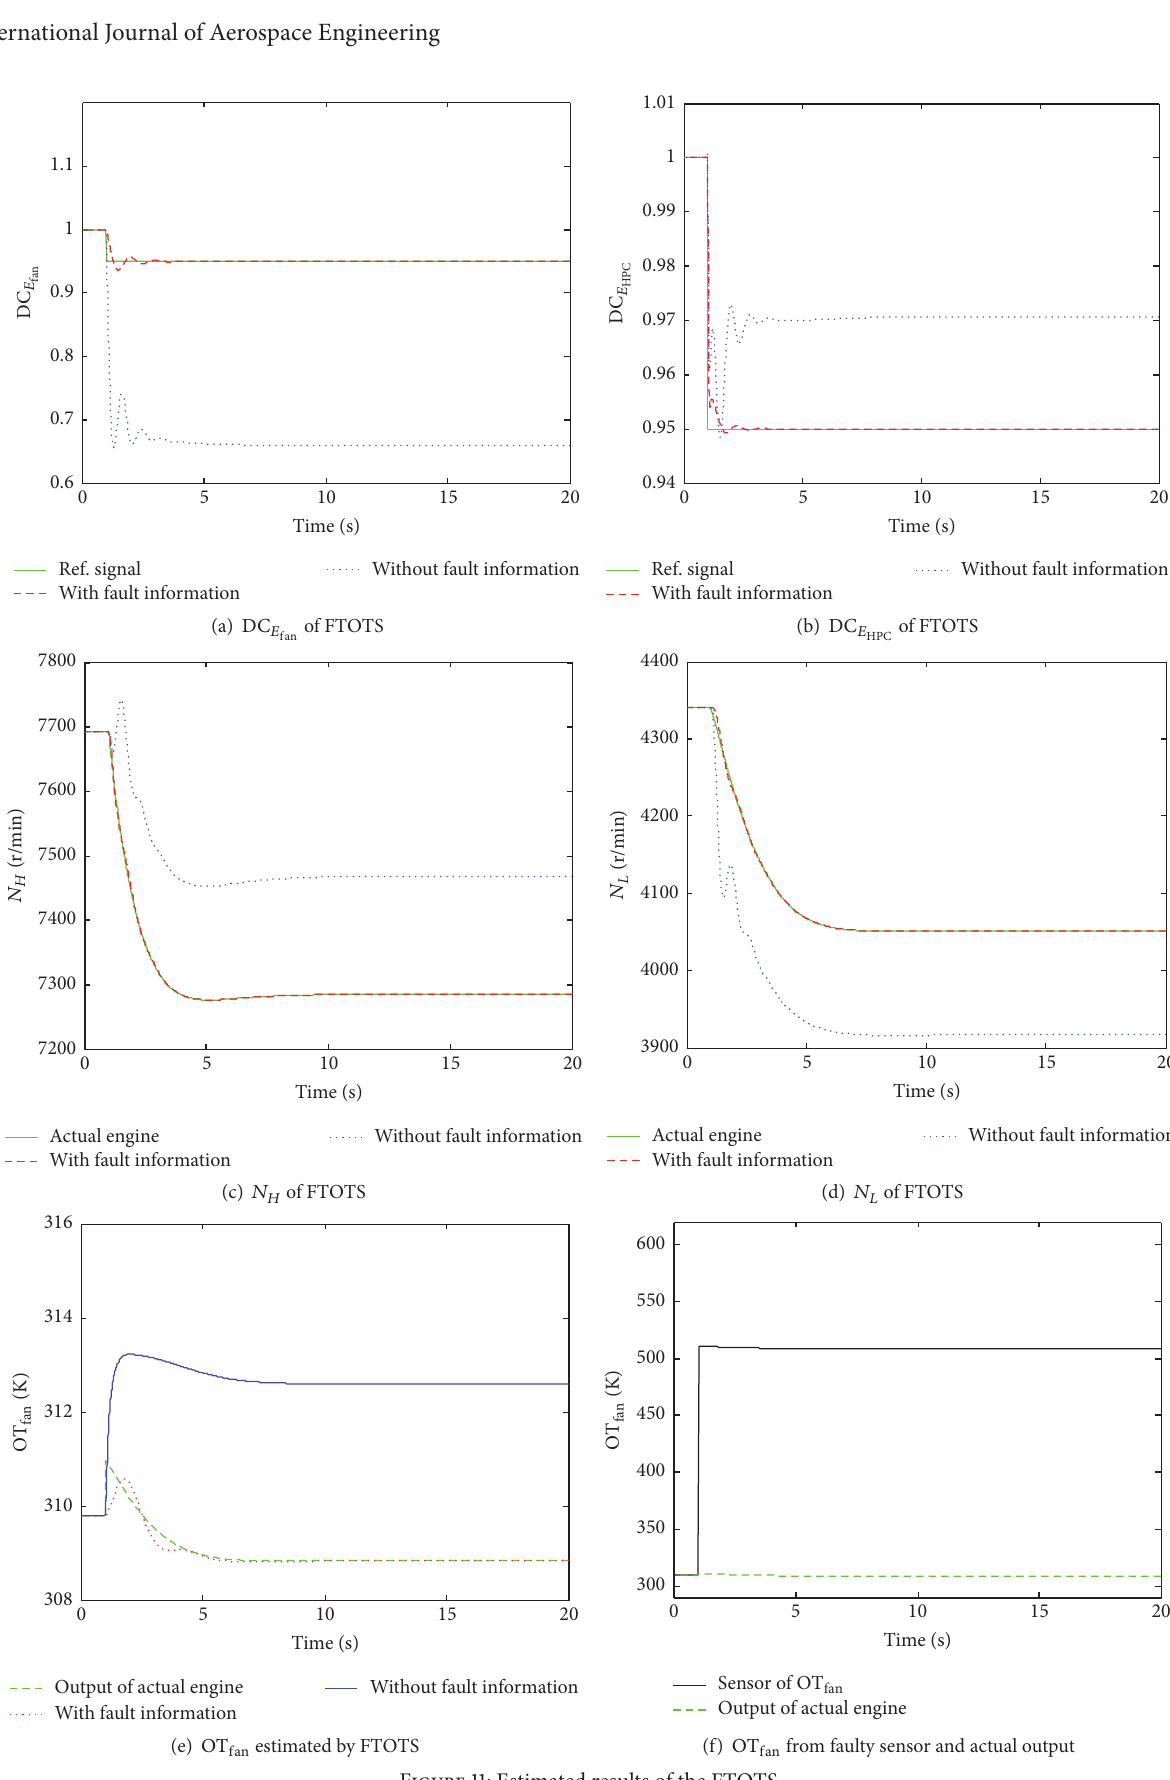
Figure 11: Estimated results of the